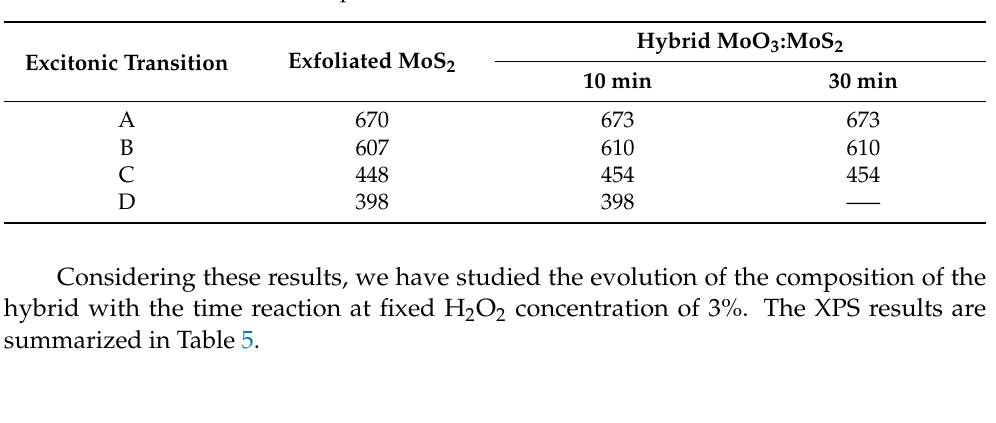
Figure 10. Absorbance spectra of exfoliated MoS 2 (blue line) and MoO 3 :MoS 2 dispersion as function of reaction durations of 10 min (pink line) 30 min (orange line) .